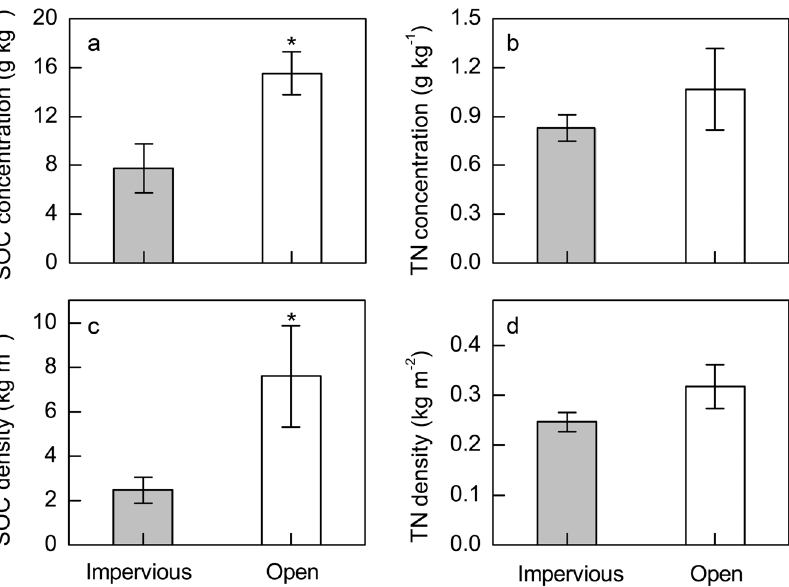
Figure 2. The concentrations and densities of SOC and TN for the impervious-covered and open soils in Yixing city. Values are means 6 SE, SOC represents soil organic carbon, and TN represents total nitrogen, * P , 0.05 ( n =7 for urban impervious-covered soils, and n =6 for urban open soils).